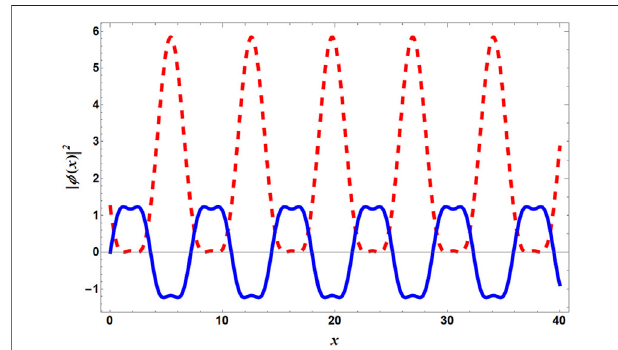
FIGURE 13 | (Color Online) The density pro fi le calculated from Eq. 36 is depicted here along with V BOL . The red dashed line and the blue solid line describe the density variation and V BOL , respectively. Here, V 1 = 1.0,